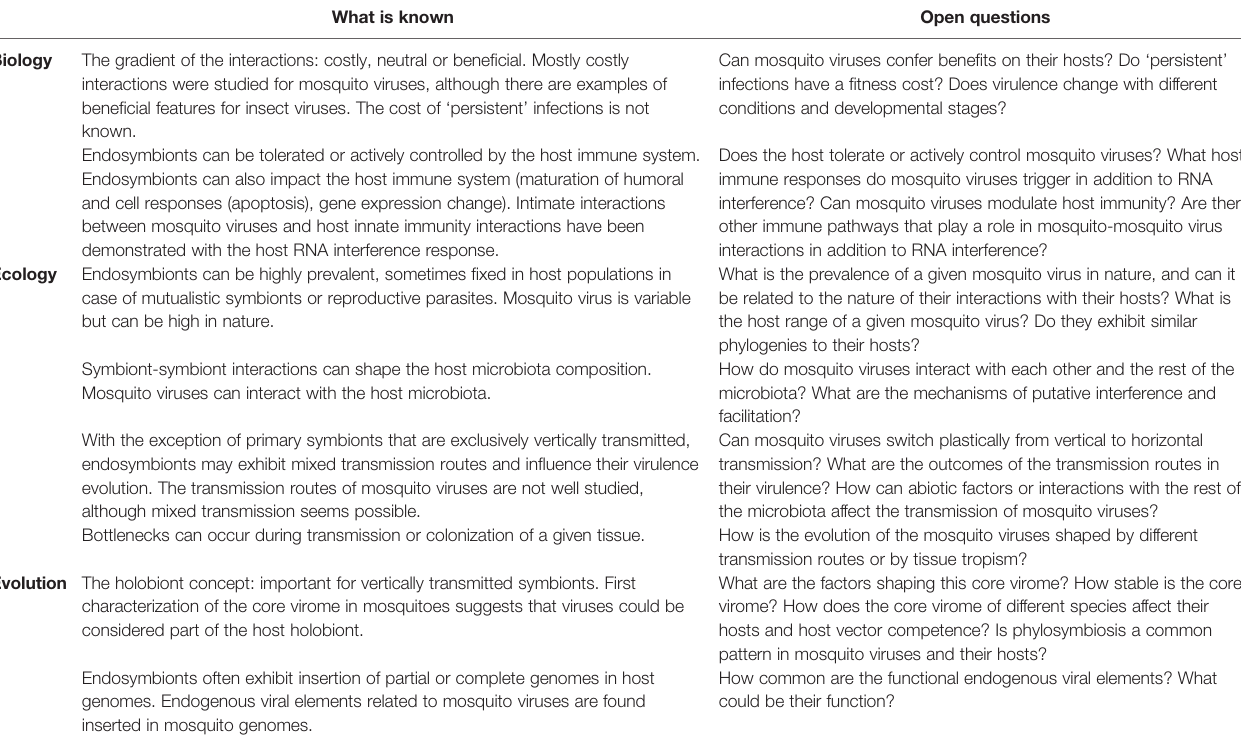
TABLE 1 | Summary and open